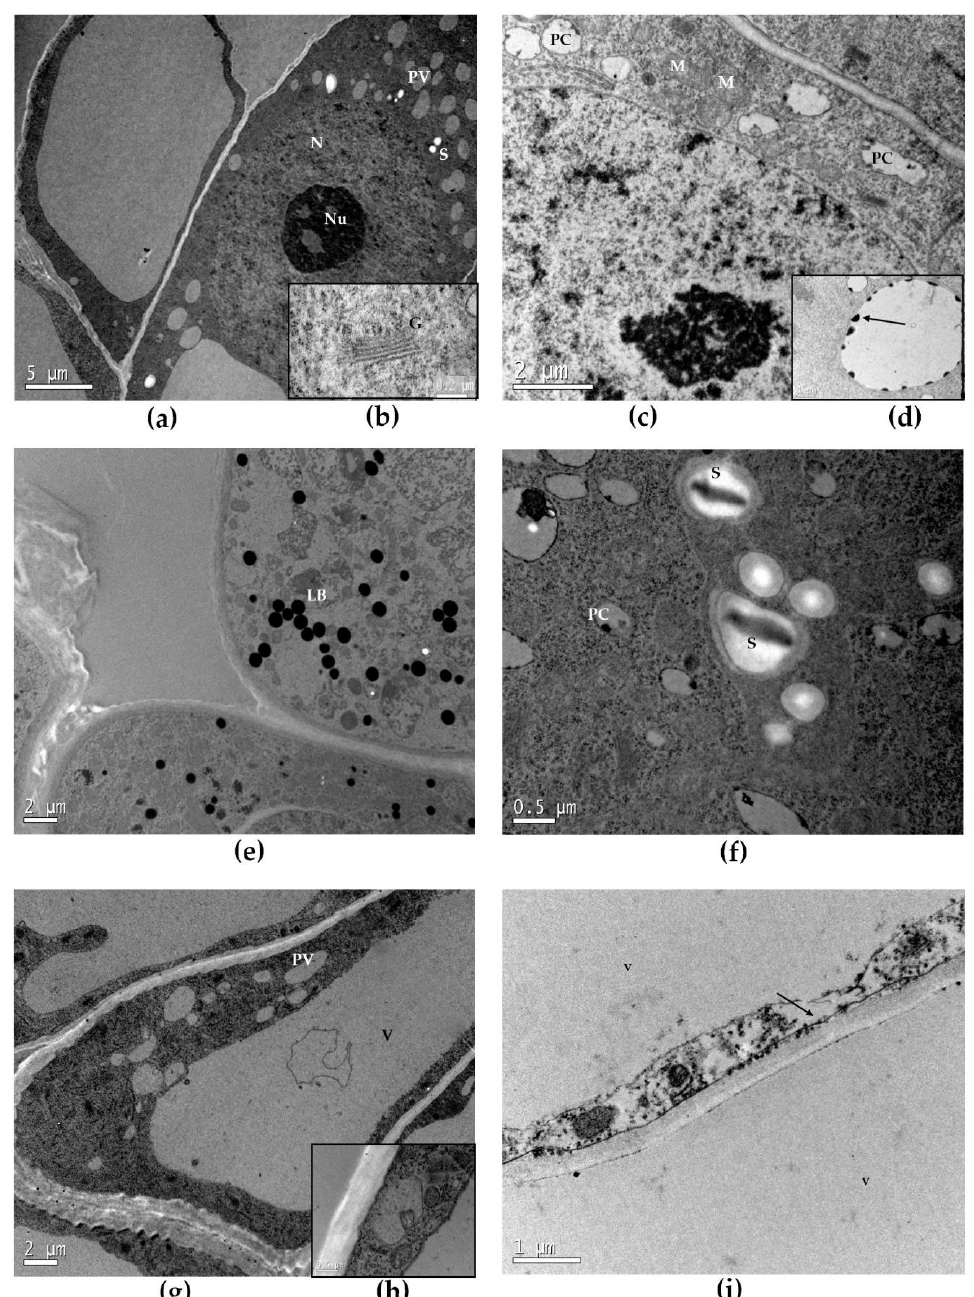
Figure 4. TEM analysis of embryogenic cultures. ( a ) Densely cytoplasmatic EC from control treatment (23 ° C), with a large central nucleus (N) and a prominent nucleolus (Nu), cytoplasmatic provacuoles (PV) and starch grains (S) inside amyloplasts; ( b ) Detail of the cytoplasm of an embryogenic cell showing a Golgi apparatus (G); ( c ) EC from 50 °C treatment where some mitochondria (M) and vacuoles containing phenolic compounds (PCs) can be seen; ( d ) Detail of PCs (arrow) inside a vacuole; ( e ) EC from cultures at 23 ° C with high amount of lipid bodies (LB); ( f ) TLC from 40 °C treatment with the presence of S and PCs; ( g ) TLC from 60 °C treatment showing a large vacuole (V) and the regression of the cytoplasm where organelles are scarce and presents smaller provacuoles (PV); ( h ) detail of the degenerating cytoplasm pressed between the cell membrane and the tonoplast ( i ) Section of two SCs with a large central V and few degenerated organelles in a thin layer of cytoplasm